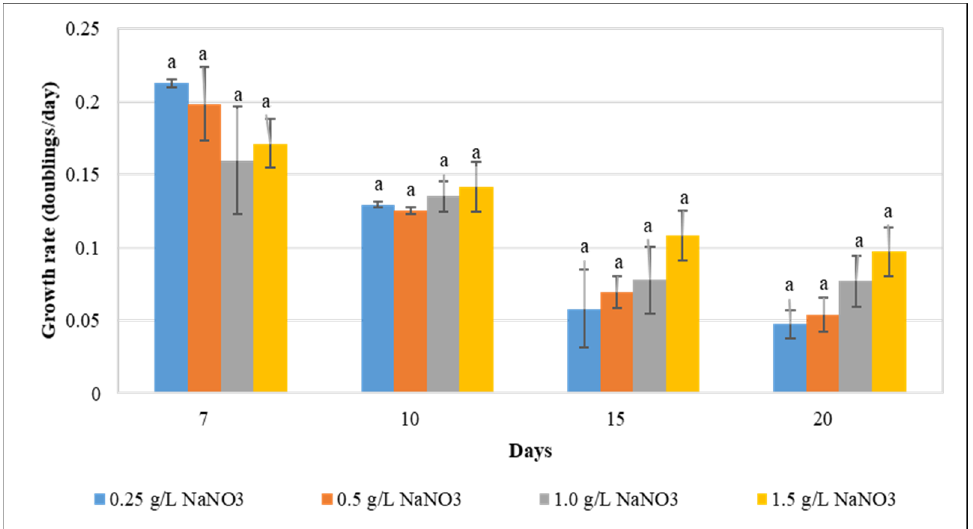
Figure 1. The impact of varying sodium nitrate (NaNO 3 ) concentrations (0.25, 0.5, 1.0, and 1.5 g L − 1 ) on Fremyella diplosiphon growth rate over a period of 7, 10, 15, and 20 days. The average growth rate (± standard error) for three biological replicates for each treatment is shown. Different letters above bars indicate significance among treatment means ( p < 0.05).